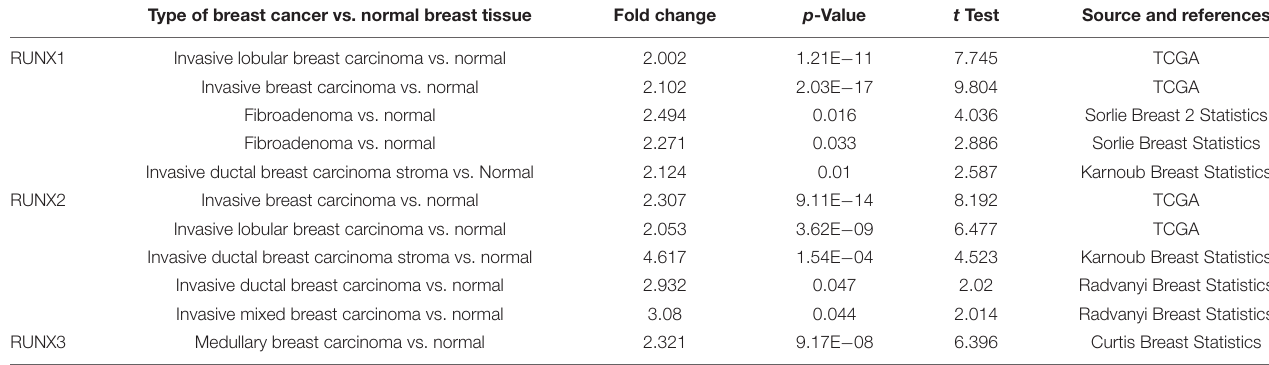
FIGURE 3 | Correlation analysis between RUNX1 expression and breast cancer patient characteristics. The RUNX1 expression levels in breast cancer patients classified by (A) TP53 mutation status, (B) individual cancer stages, (C) breast cancer subclasses, and (D) histological subtypes were shown. TABLE 1 | The significant changes of Runt-related transcription factor (RUNX) transcriptional levels in different types of breast cancers vs. normal breast tissues (oncomine database). Type of breast cancer vs. normal breast tissue Fold change p -Value t Test Source and